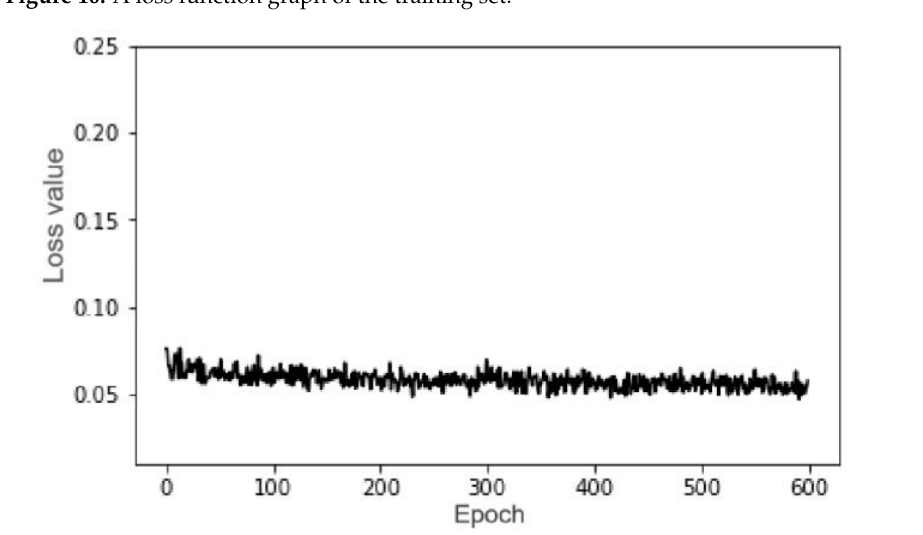
Figure 11. A loss function graph of the testing